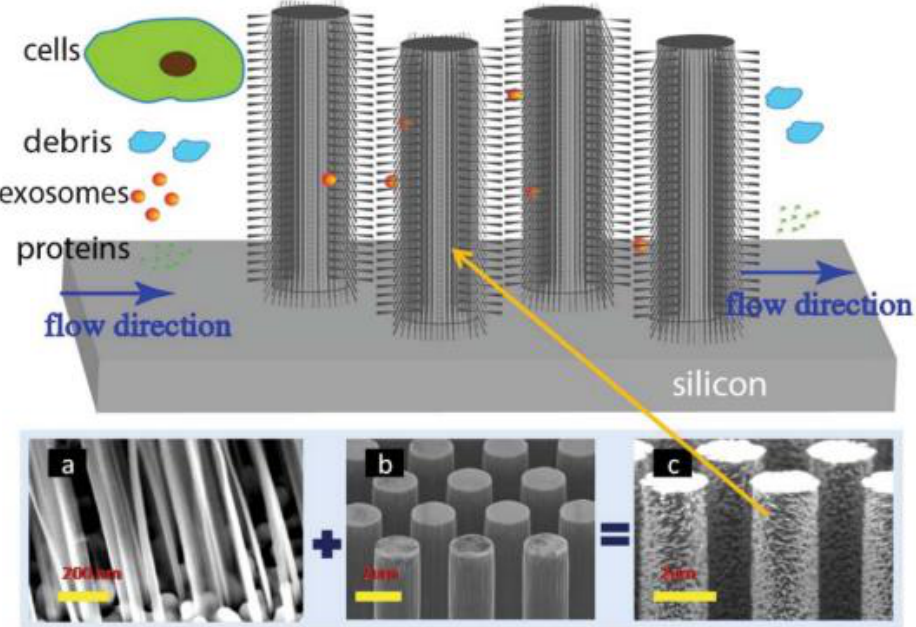
Figure 8. Schematic of the ciliated micropillar array. ( a ) representative porous silicon nanowire forest. ( b ) micropillars. ( c ) representative ciliated micropillars. (Reproduced from Wang Z. et al. [72]. Copyright 2013, Lab Chip).